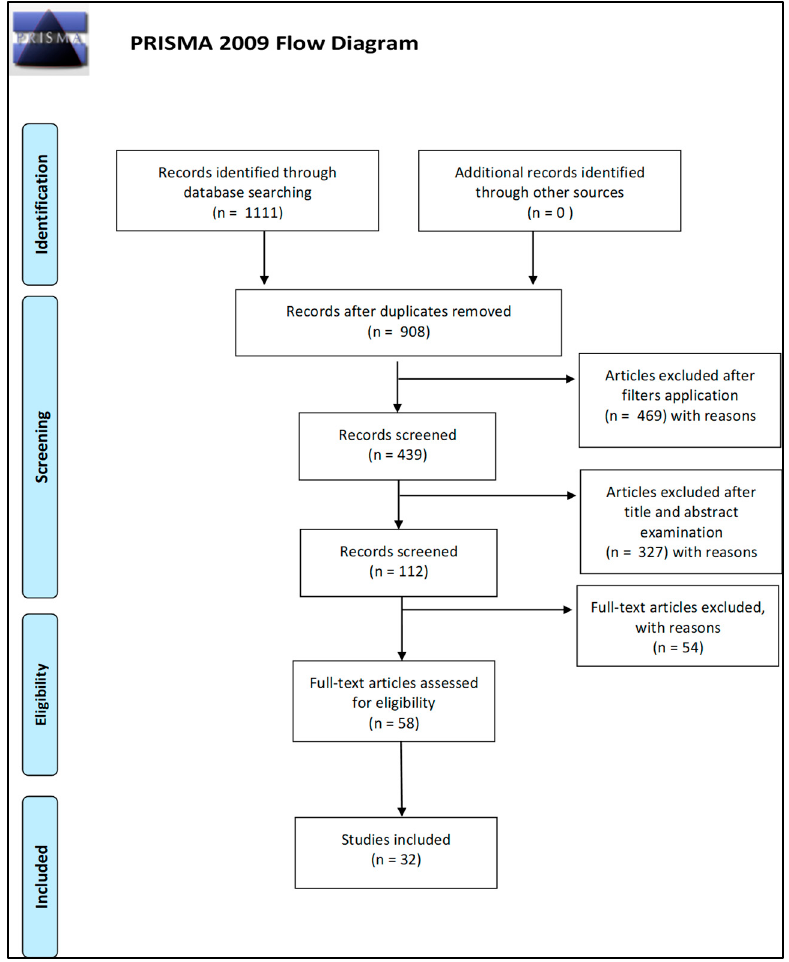
Figure 1. Preferred Reporting Items for Systemic Reviews and Meta-Analyses (PRISMA) 2009 flow diagram.